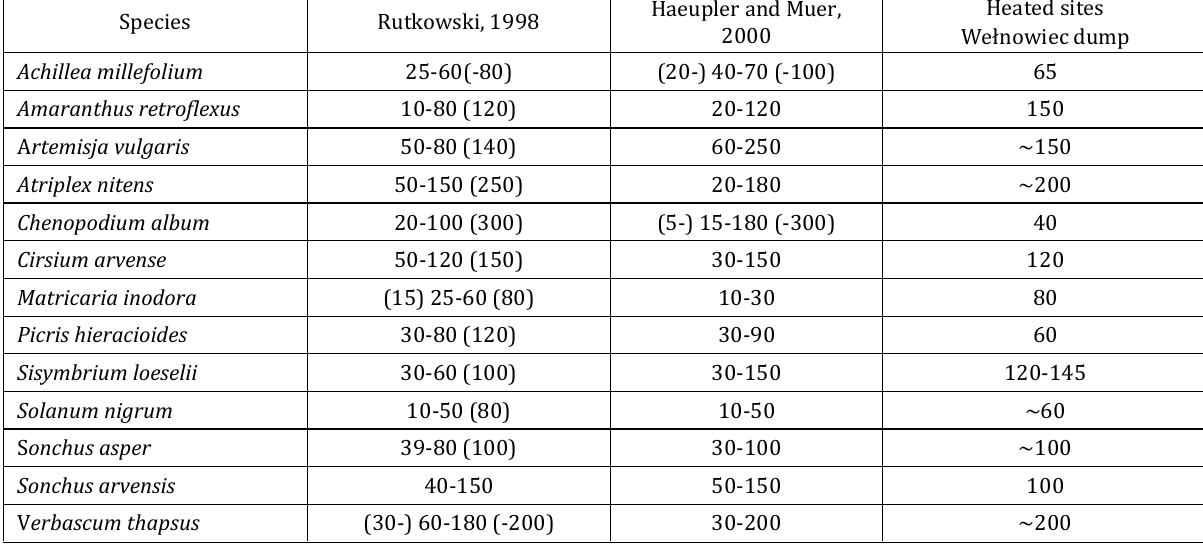
Table 2. Sizes of selected species observed on overburned sites in the Wełnowiec dump compared to literature data